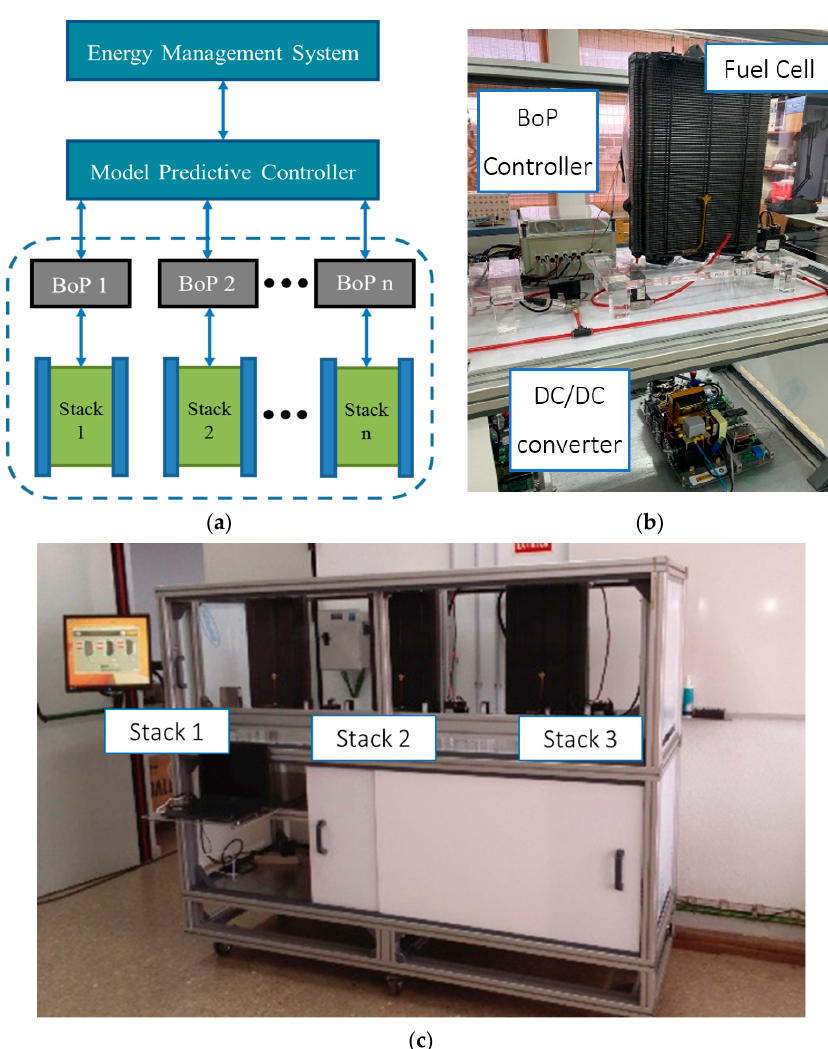
Figure 2. ( a ) Block Diagram and model predictive control (MPC) control architecture for a multi-stack fuel cell (FC) system; ( b ) detail of a single fuel cell (stack + BoP + power electronics); ( c ) detail of the real multi-stack system integrated into the microgrid. Table 2. FCgen-1020ACS stack technical characteristics.